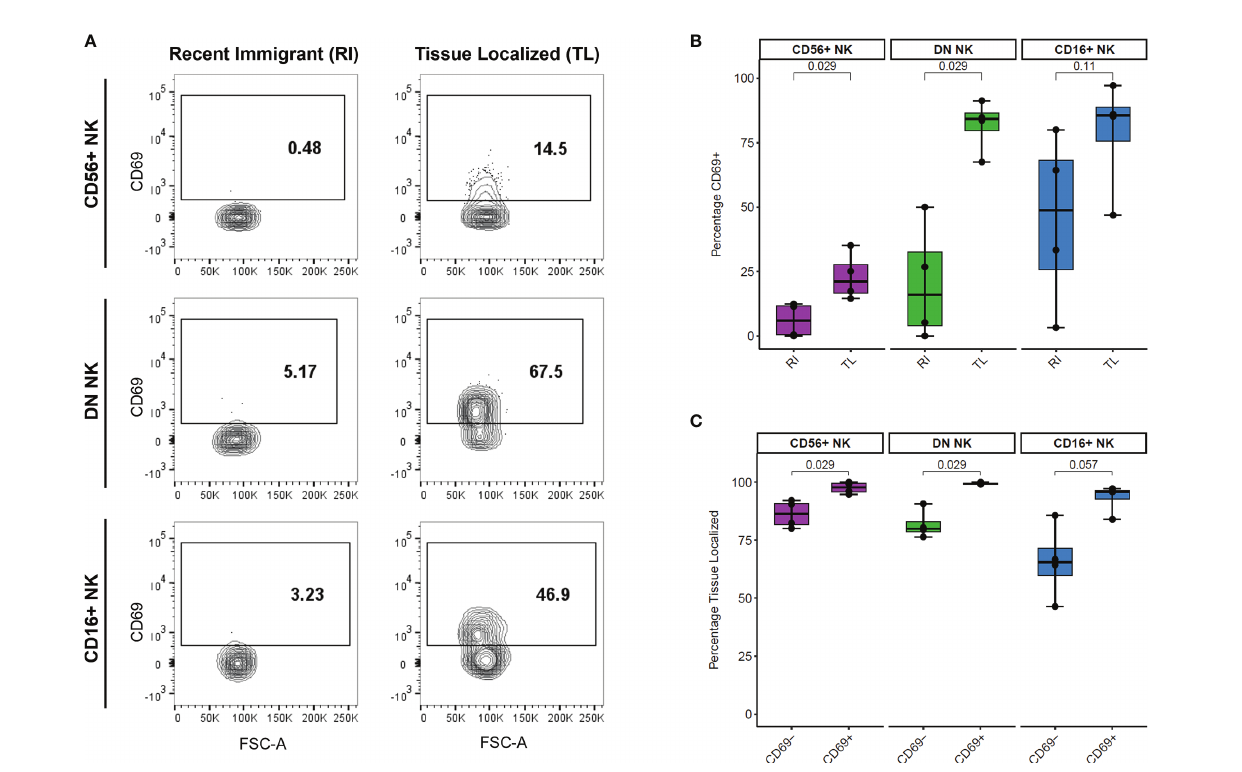
FIGURE 4 | Association between CD69 surface levels and tissue localization in LN NK cells. (A) Representative CD69 surface marker levels compared between Recent Immigrant (RI) and Tissue Localized (TL) cells within each NK subset from animal TID axillary lymph node sample. RI cells are IVAS- but stained positive for at least one other timepoint, while TL cells stained negative for all SIVS infusions. (B) Comparison of the percentage of cells positive for CD69 between RI and TL NK cells from each NK subset from four animals axillary lymph node. Each dot shows the percentage in one animal ’ s AxLN sample (n = 4 for each NK subset). The box shows interquartile ranges, and the whiskers extend to the furthest data point. P-values are from a Wilcoxon test comparing each NK subset. (C) Comparison of the proportion of cells which were Tissue Localized (TL) within the CD69- and CD69+ subset from each NK cell subset from four animals axillary lymph node sample. Box plots are the same as in panel (B) and p-values are from a Wilcoxon test comparing each NK subset (n = 4 for each